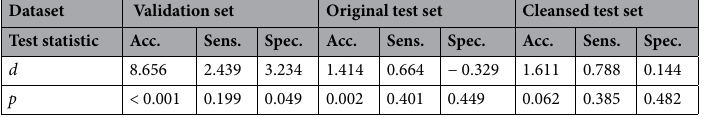
Table 3. Effect size d and p -value of enhancement after application of UDC on embryo